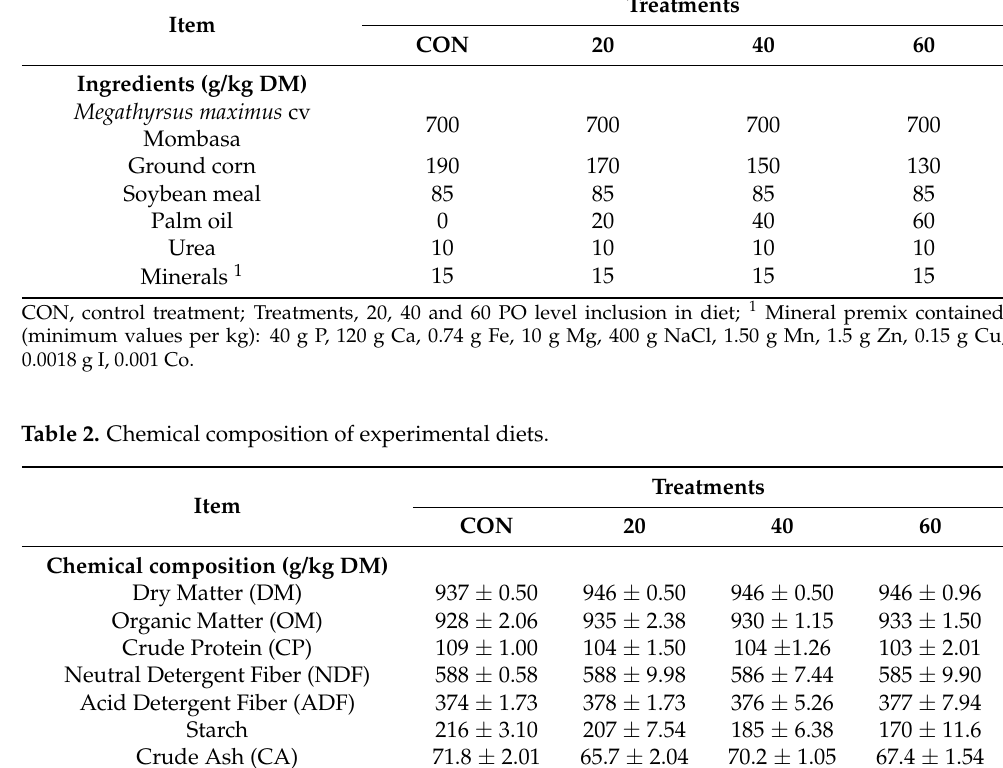
Table 1. Proportion of ingredients of experimental diets. Item